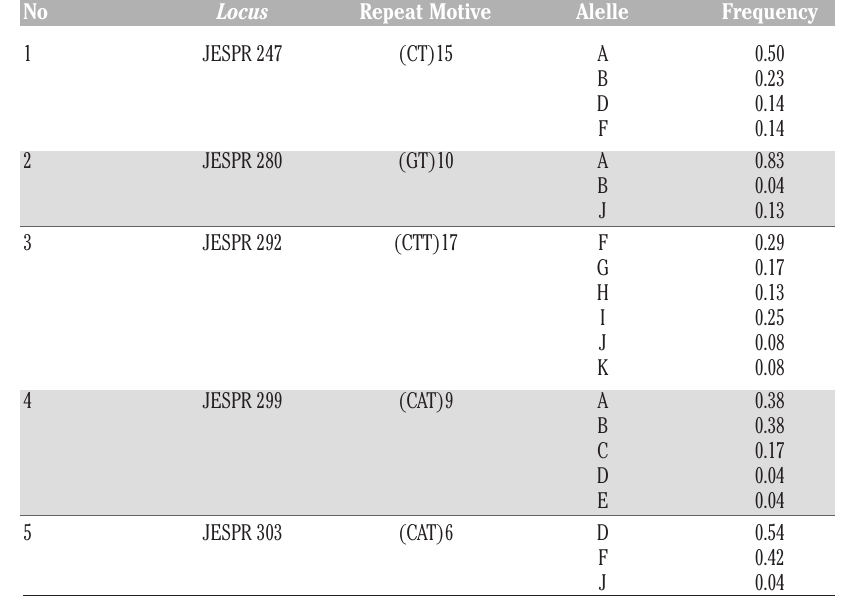
Table 2. Allele frequencies at five microsatellite loci of 12 sampled superior cotton vari- eties.